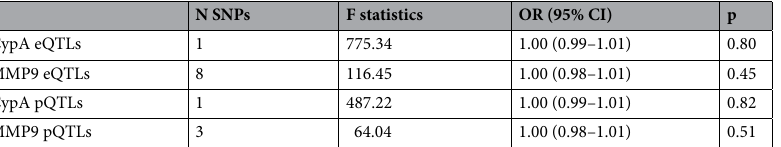
Table 1. Causal effects of CypA and MMP9 eQTLs and pQTLs on risk of Alzheimer’s disease. Causal effect estimates are interpreted as the odds of Alzheimer’s disease per standard deviation increase in CypA and MMP9 eQTLs or